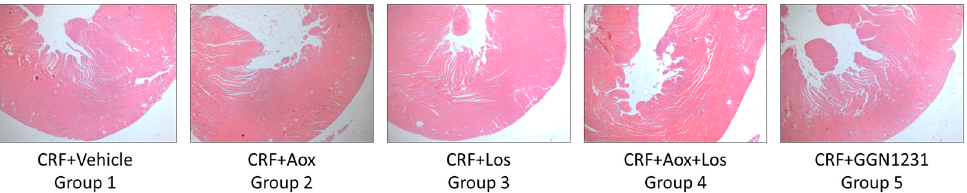
Figure 4. Representative images of hematoxylin-eosin staining for the hearts used to analyze the parameters of cardiac hypertrophy are described in Table 3. CRF (chronic renal failure); Aox (antioxidant); Los (losartan); Aox+Los (antioxidant plus losartan); GGN1231 (antioxidant plus losartan hybrid). Table 3. Parameters of cardiac hypertrophy.